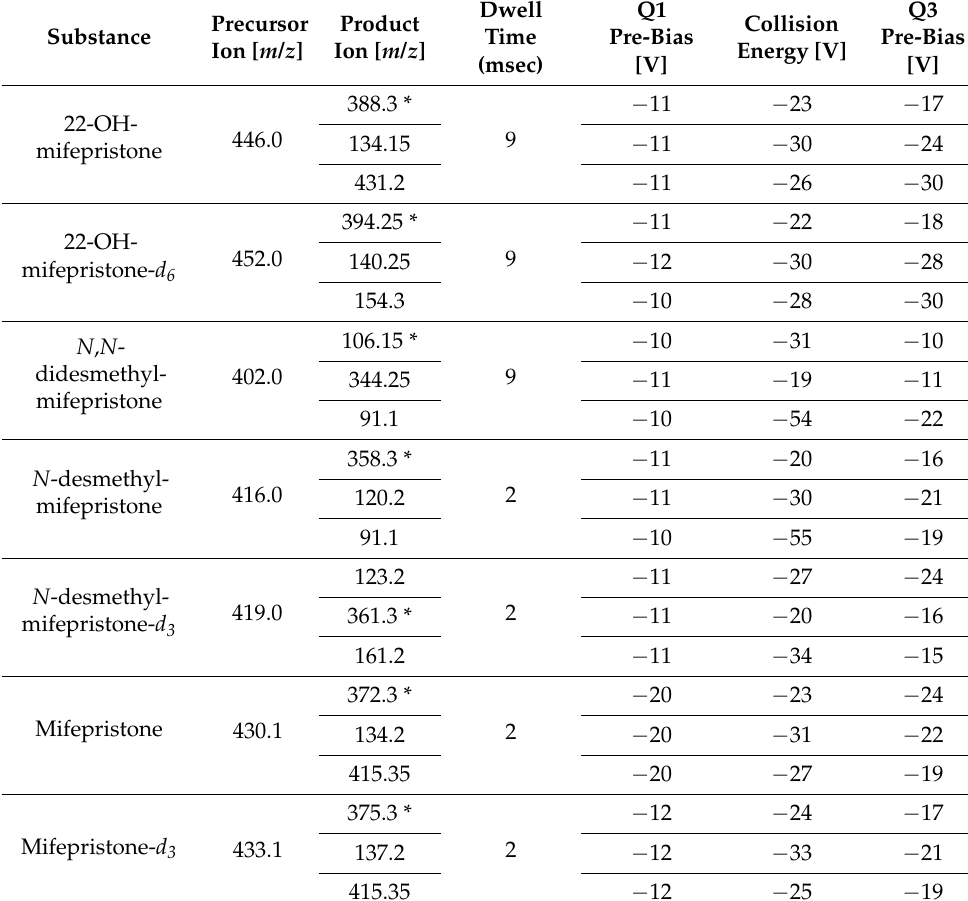
* Ions selected for quantitative